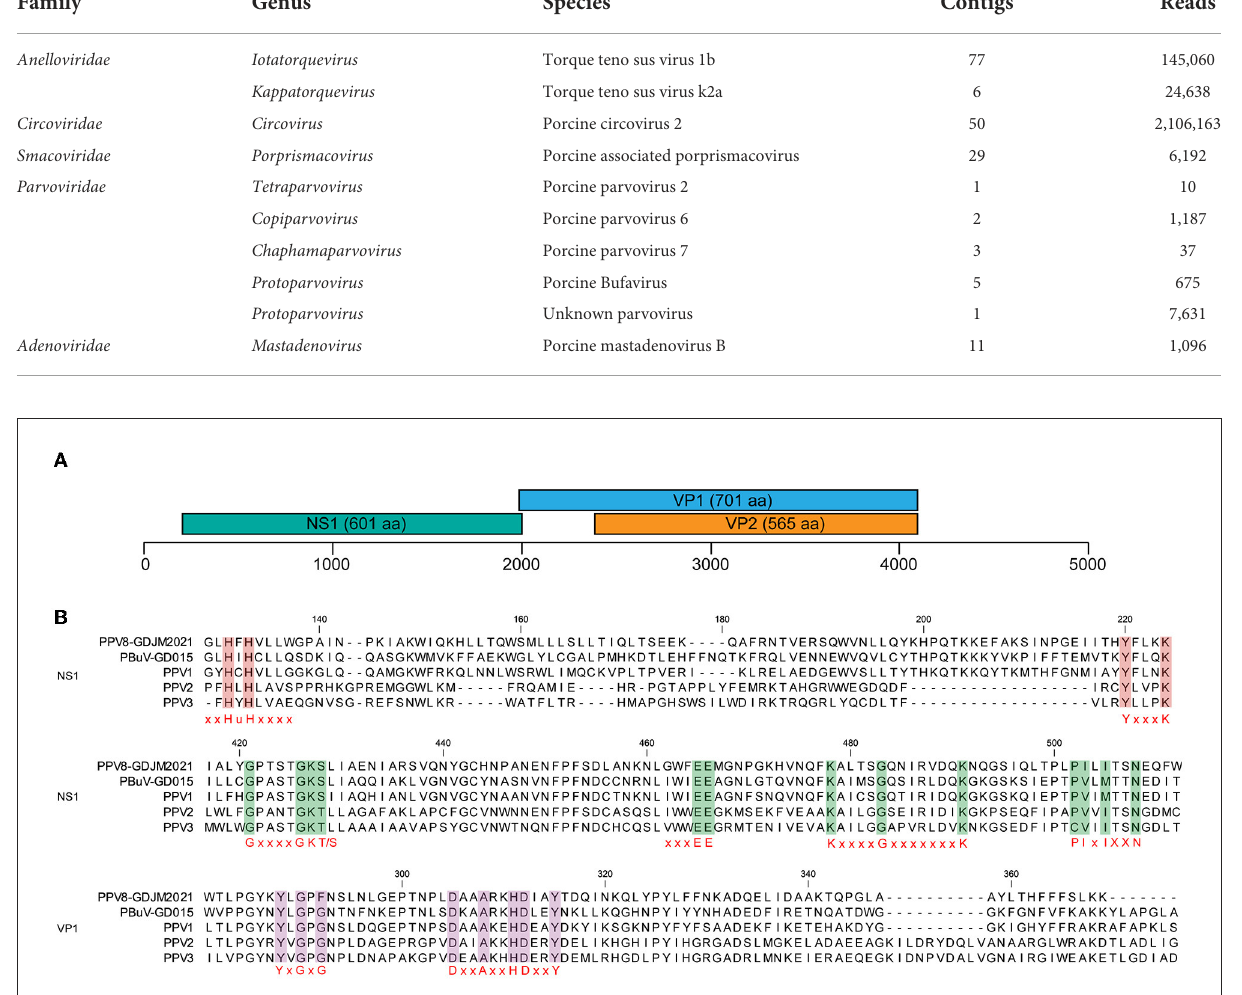
FIGURE1 Genomic structure of PPV8-GDJM2021 (A) and multiple sequence alignment of the motif of PPV8-GDJM2021 with those of other parvoviruses (B) . (A) predicted ORFs encoding structural and non-structural proteins are indicated by boxes of different colors. The position and size of putative ORFs are indicated. (B) the conserved motifs in both the helicase domain in the NS1 proteins and the phospholipase A2 (PLA-2) domain in the VP1 proteins of PPV8-GDJM2021 and other porcine parvovirus, including, xxHuHxxxx (GLHFHVLLW) and YxxxK (YFLKK), Walker motifs (A, B, B’, and C), calcium binding domain and enzymatic core